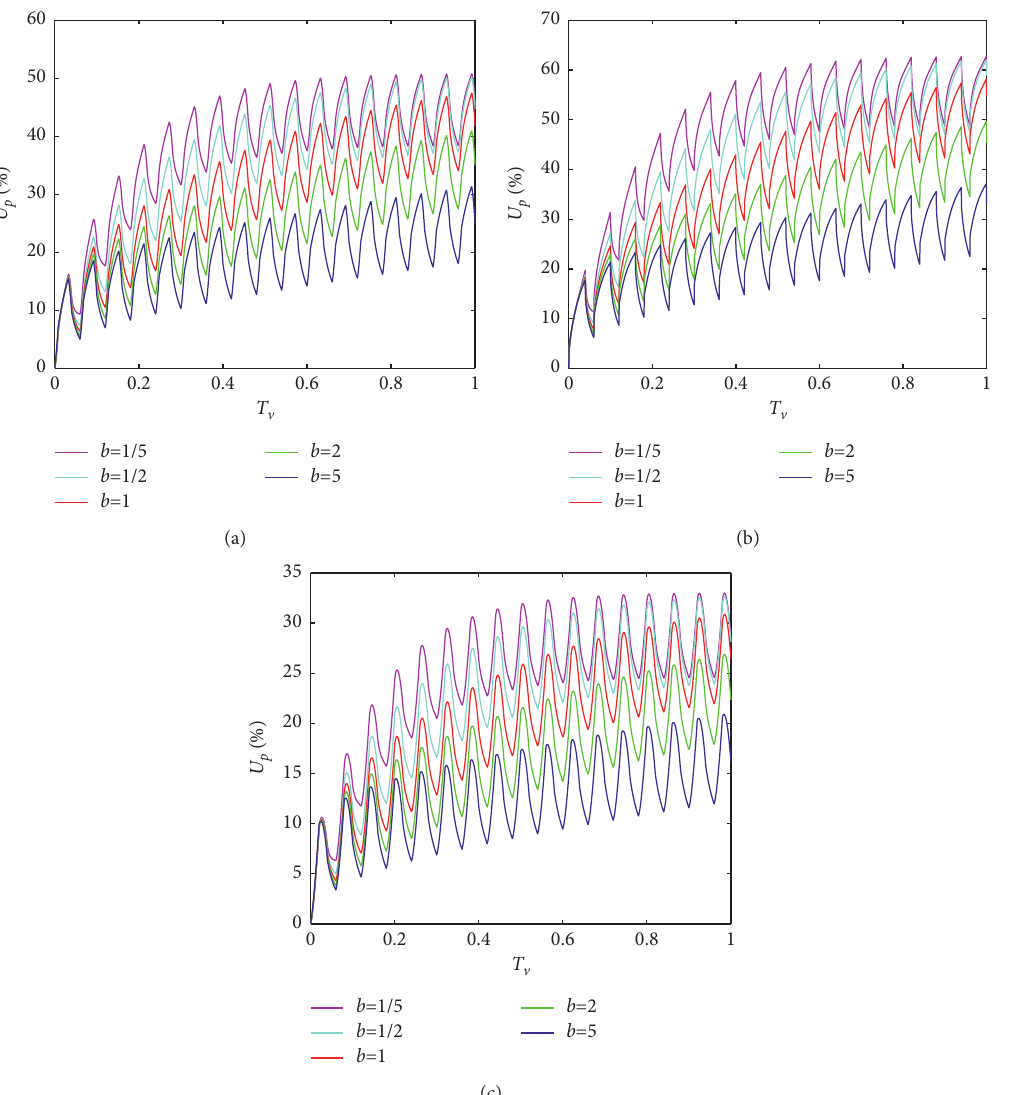
Figure 9: The variations of average degree of consolidation U